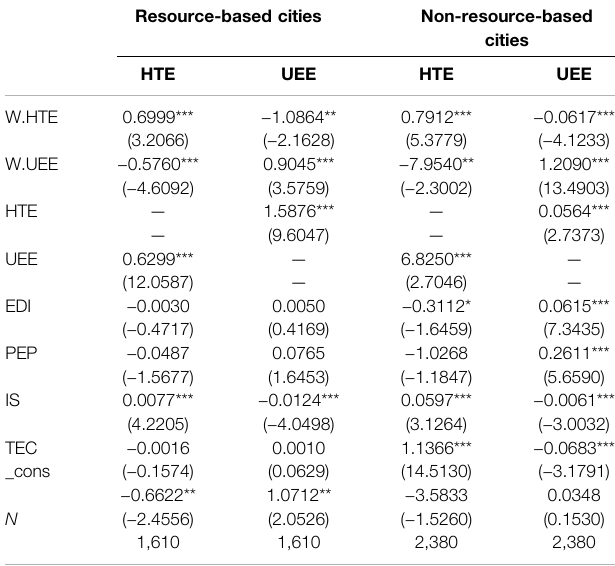
TABLE 6 | Estimation results of cities by resource Endowment (economic- geospatial weight matrix). Resource-based